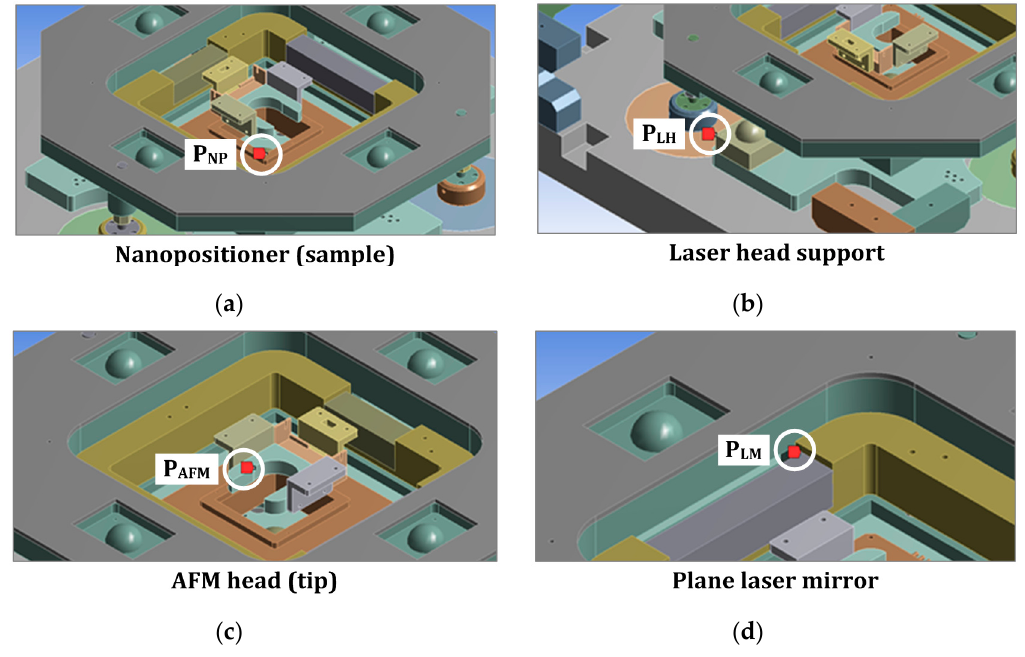
Figure 4. Analyzed points of the metrology loop of the detailed FEA simulations. ( a ) P NP , nanopositioner; ( b ) P LH , laser head; ( c ) P AFM , AFM head; ( d ) P LM , laser mirror.